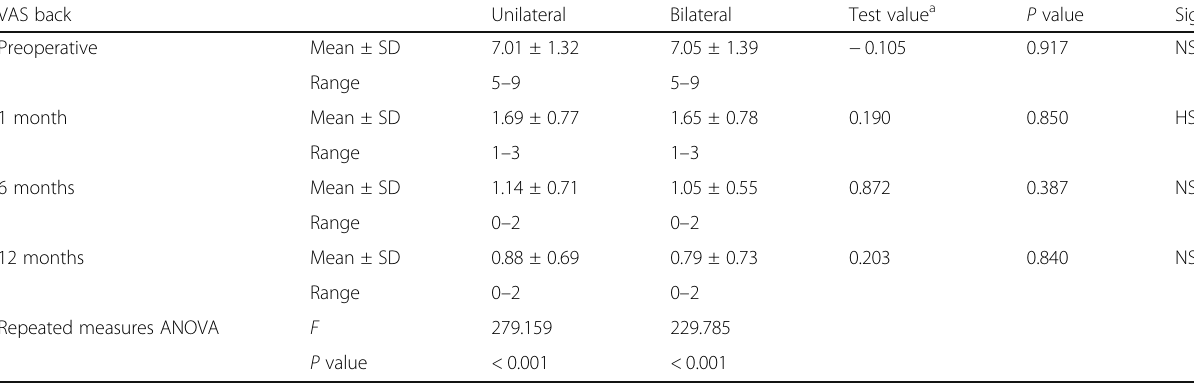
Table 2 Comparison between unilateral group and bilateral group regarding the visual analogue scale for leg pain VAS back Unilateral Bilateral Test value a P value